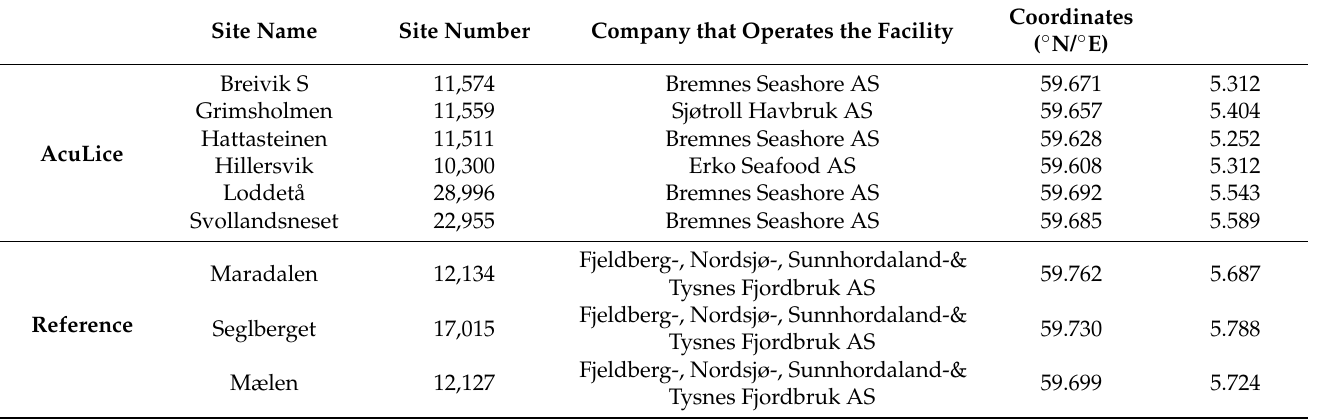
Table 1. Field trial 2 facilities divided into the two treatment groups (AcuLice or reference), with the site number, company that operates the facility, and coordinates of the location of the